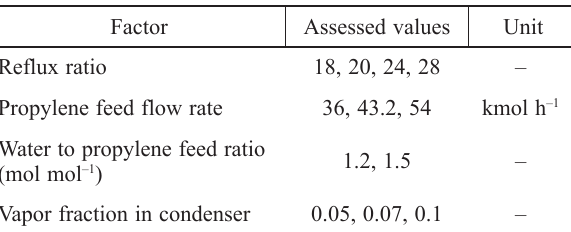
Table 1 – Values of operating variables used for